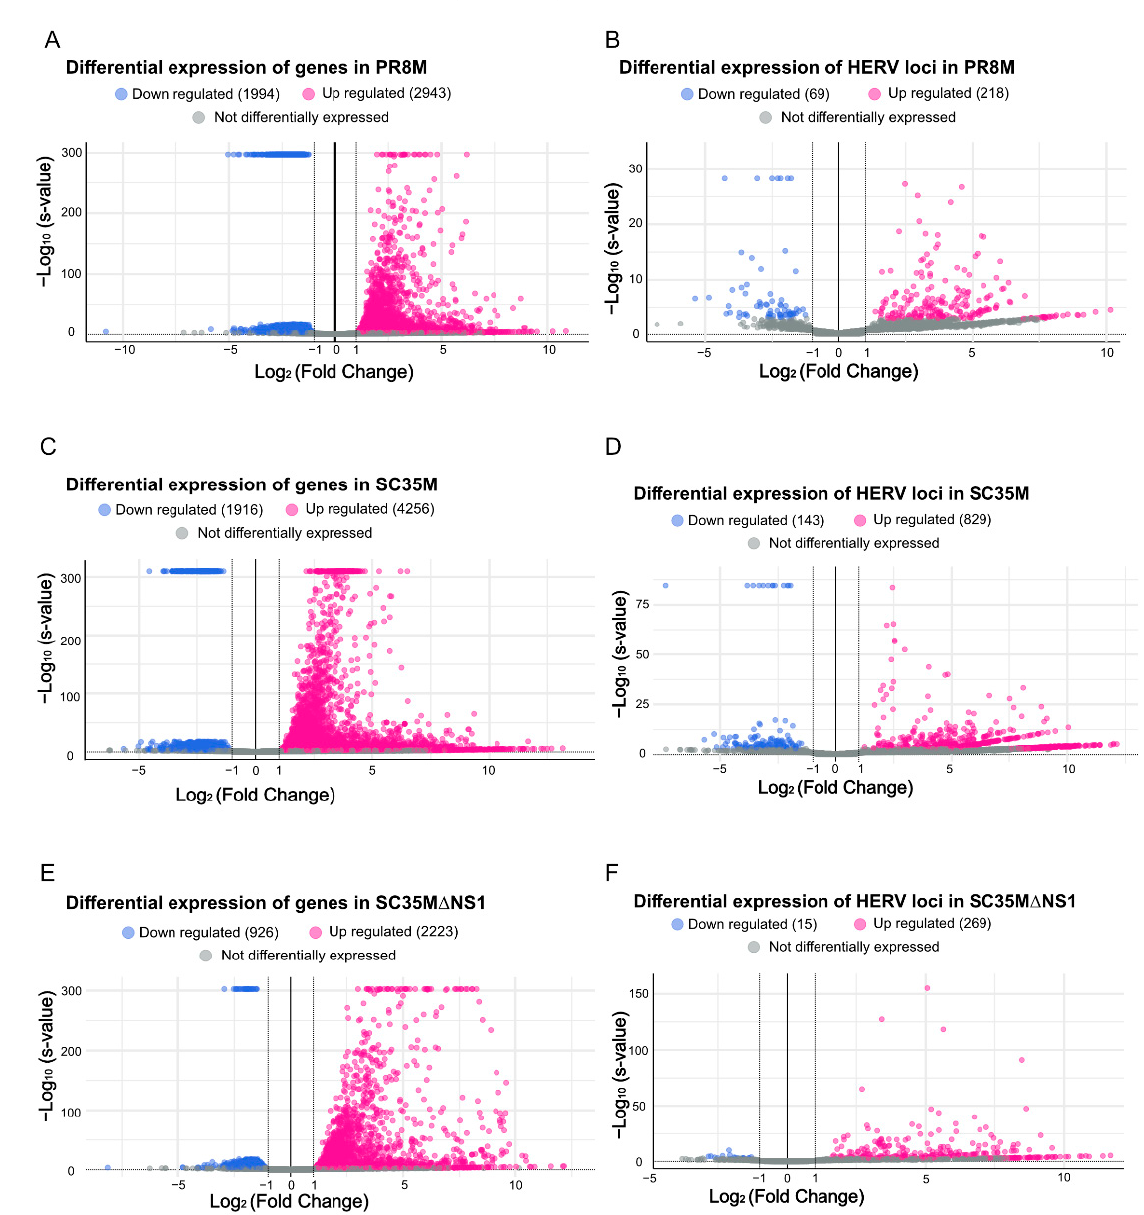
Figure 2. Volcano plots illustrating the differential expression of genes and HERV loci in all three cell lines compared to the mock control. ( A , B ) Differential expression genes and HERV loci in PR8M. ( C , D ) Differential expression of genes and HERV loci in SC35M. ( E , F ) Differential expression genes and HERV loci in SC35M ∆ NS1. DESeq2 converts very small s-values to 0, which leads to 580 genes in PR8M, 343 in genes in SC35M, and 75 genes in SC35M ∆ NS1 all having the same -Log10 ( s -value) and appearing at the top.